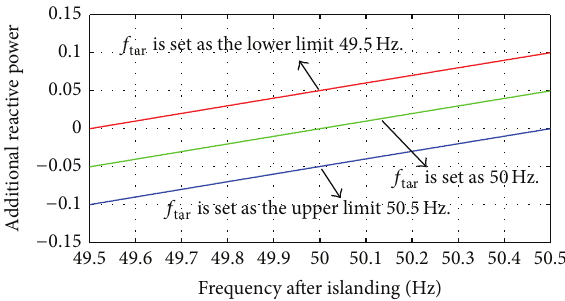
Figure 3: The Δ𝑄 - 𝑓 1 curves when 𝑓 threshold